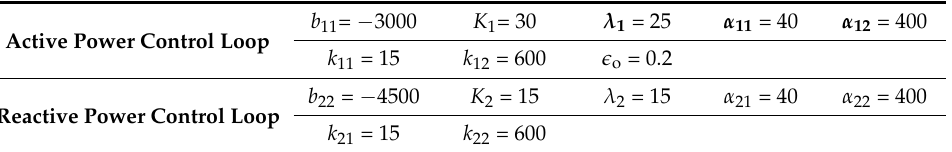
Table 1. The control parameters of